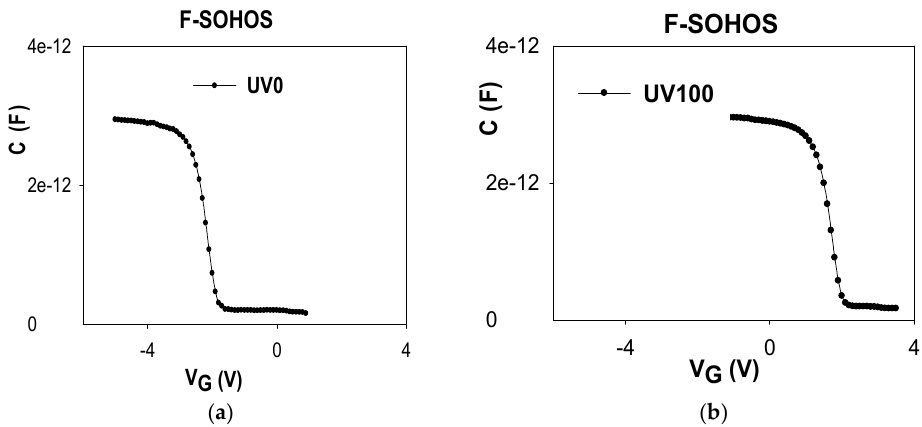
Figure 2. This C G -V G curve for an F-SOHOS capacitor device ( a ) before UV irradiation; ( b ) after UV TD 100 mW s/cm 2